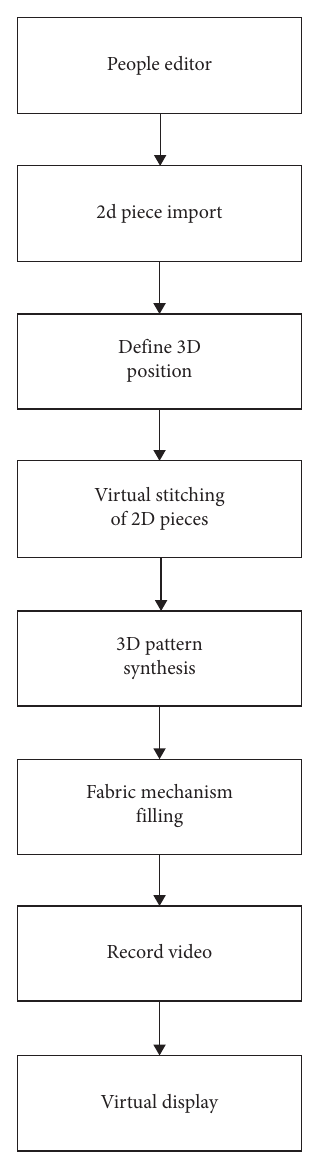
Figure 4: Operation flow chart of sewing and displaying virtual